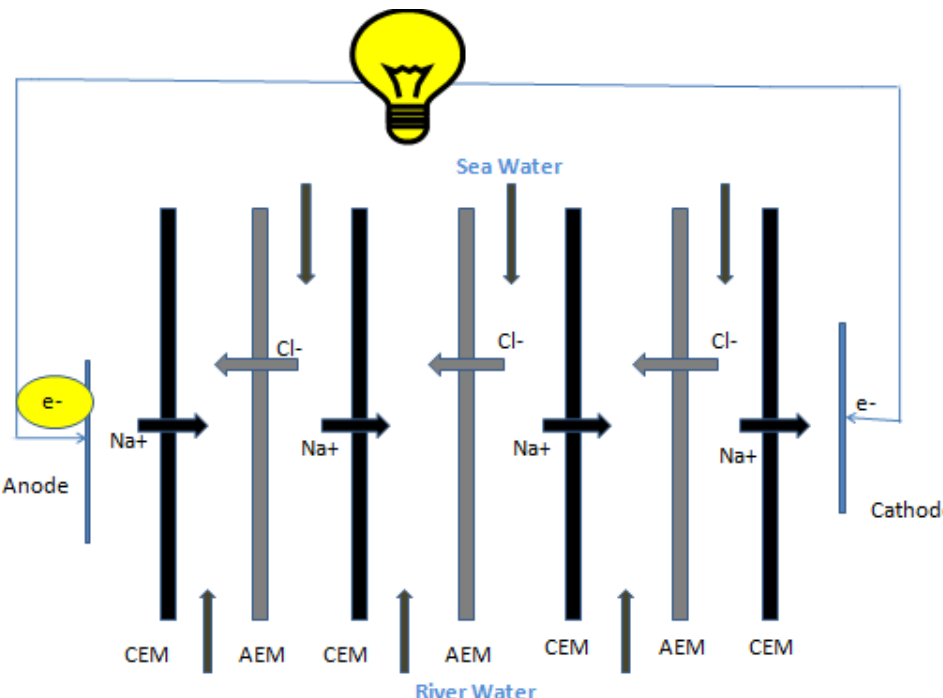
Figure 18. Functioning of energy production by the RED process.